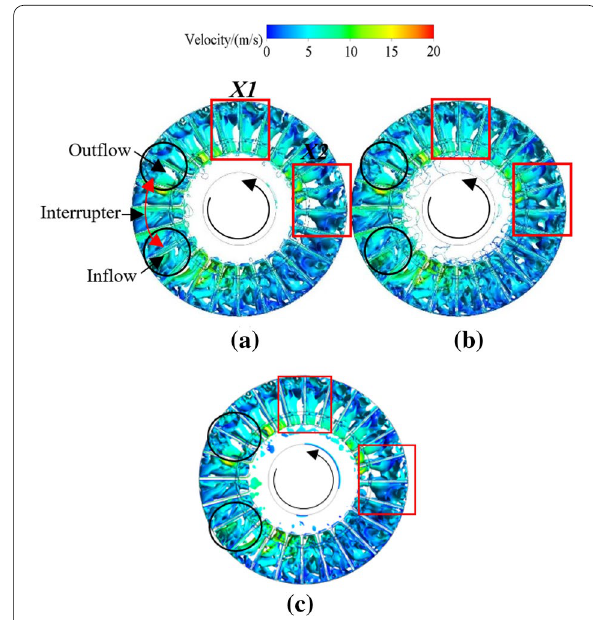
Figure 10 Vortex structures in the impeller under the three criteria